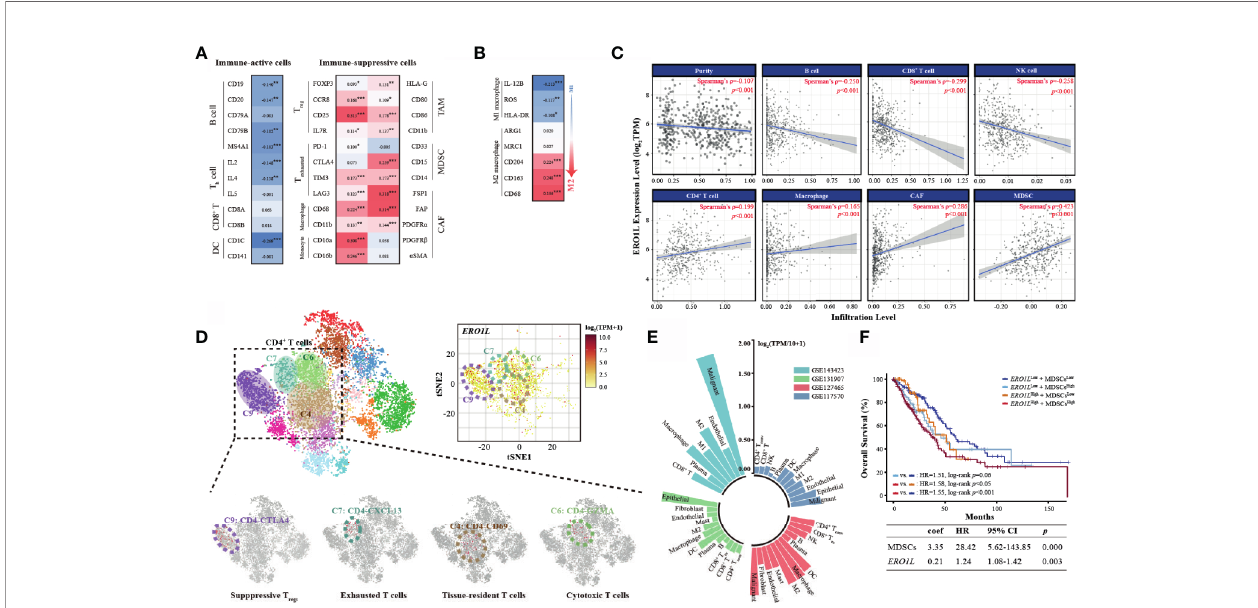
FIGURE 4 | Overexpression of ERO1L shapes an immune-suppressive tumor microenvironment. (A) Correlations between ERO1L and the immune cell markers. (B) ERO1L expression correlates with macrophages polarization. (C) ERO1L expression was signi fi cantly negatively correlated with in fi ltrating levels of B cells, CD8+ T cells, and NK cells and signi fi cantly positively correlated with in fi ltrating levels of CD4+ T cells, macrophages, CAFs, and MDSCs. (D) The intrinsic heterogeneity of CD4 + T cells according to ERO1L expression as determined via single-cell sequencing data. Each dot corresponds to a single cell and is colored according to the cell cluster. The color density indicates the expression of ERO1L . (E) Summary of four single-cell sequencing datasets according to correlations with ERO1L . Different datasets are labeled in different colors. (F) The Cox proportional hazards model is constructed according to expressions of ERO1L and MDSC. * p < 0.05; ** p < 0.01; *** p <